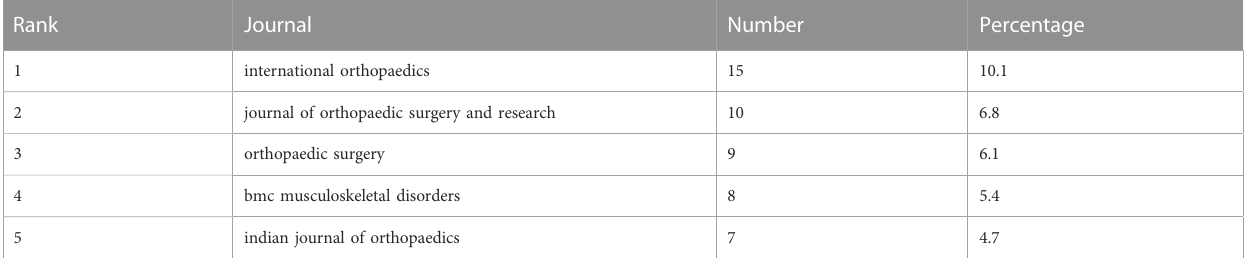
TABLE 4 Top 5 productive journals in the fi eld of additive manufacturing technology in pelvic surgery.